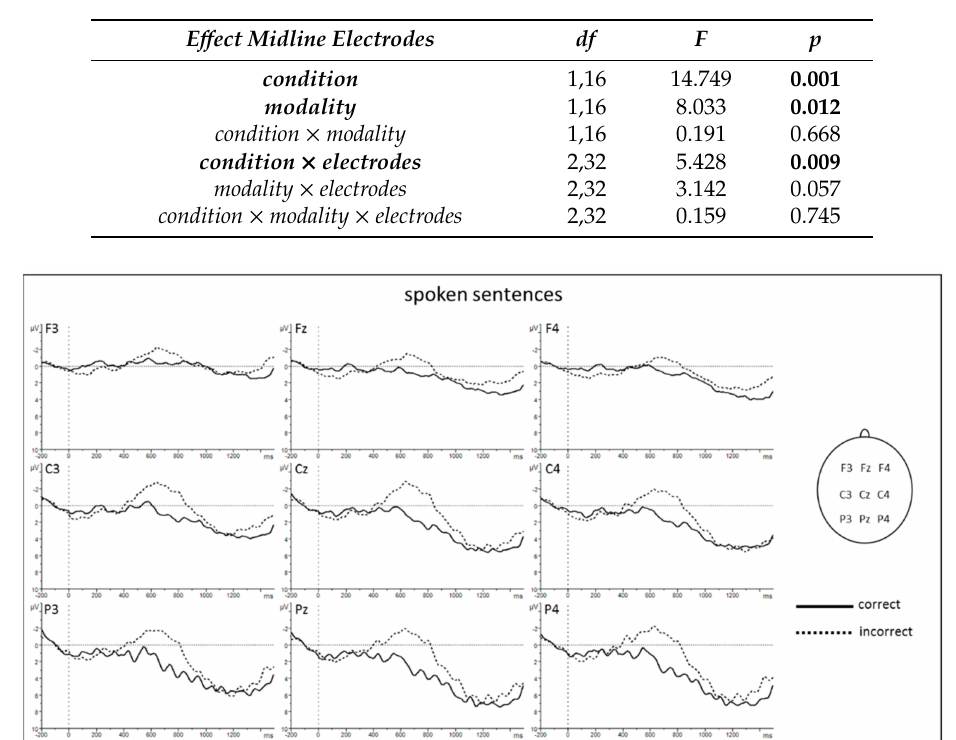
Table 2. Statistical results of the ANOVA condition × modality × region × hemisphere for ERP data on midline electrodes. Data from the time window 500–900 ms was considered for spoken sentences, while data from the time window 800–1200 ms entered analyses for sung sentences. Significant e ff ects ( p < 0.050) are marked in bold.